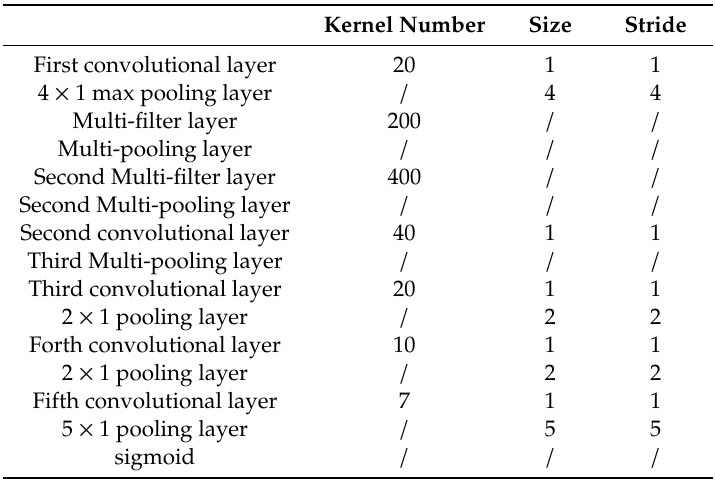
Figure 8. Experiment equipment provided by Case Western Reserve University (CWRU). Table 2. The main parameters of